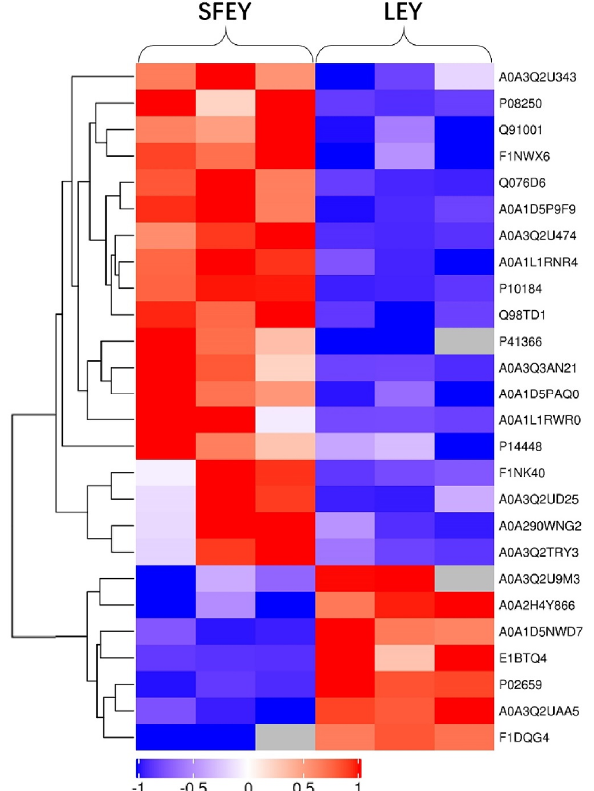
Figure 1. Profiles of differently expressed proteins identified in SFEY and LEY using cluster analysis. A total of 26 proteins were observed with significantly difference. Three biological replicates of SFEY and LEY were presented separately. Red and blue: significantly up-regulated and down-reg- ulated proteins, respectively; gray: no quantitation information. 3.2. GO Enrichment Analysis Revealed That Peptidase Regulates the Activity of Most Differentially Abundant Proteins Extensively Involved in the Coagulation Process Among the proteins with significantly higher or lower abundance, there were four domains dominated: immunoglobulin V-set domain, serpin (serine protease inhibitor), alpha-2-macroglobulin family and alpha-2-macroglobulin family N-terminal region (Fig- ure 2A). The domain enrichment (Figure 2B) indicated that the five domains with the larg- est enrichment factors were serpin (serine protease inhibitor), alpha-2-macroglobulin fam-